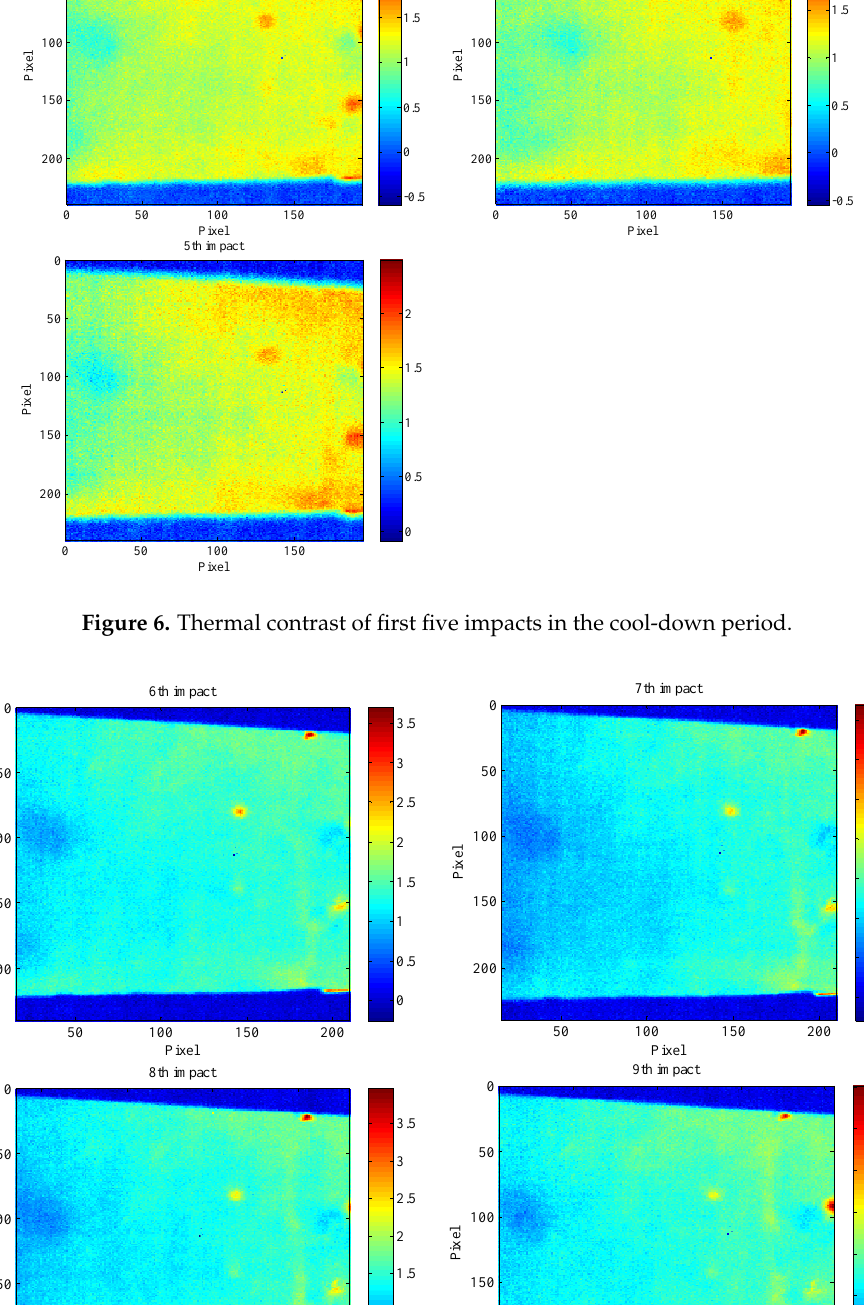
Figure 7. Thermal contrast of last four impacts in the cool ‐ down period.